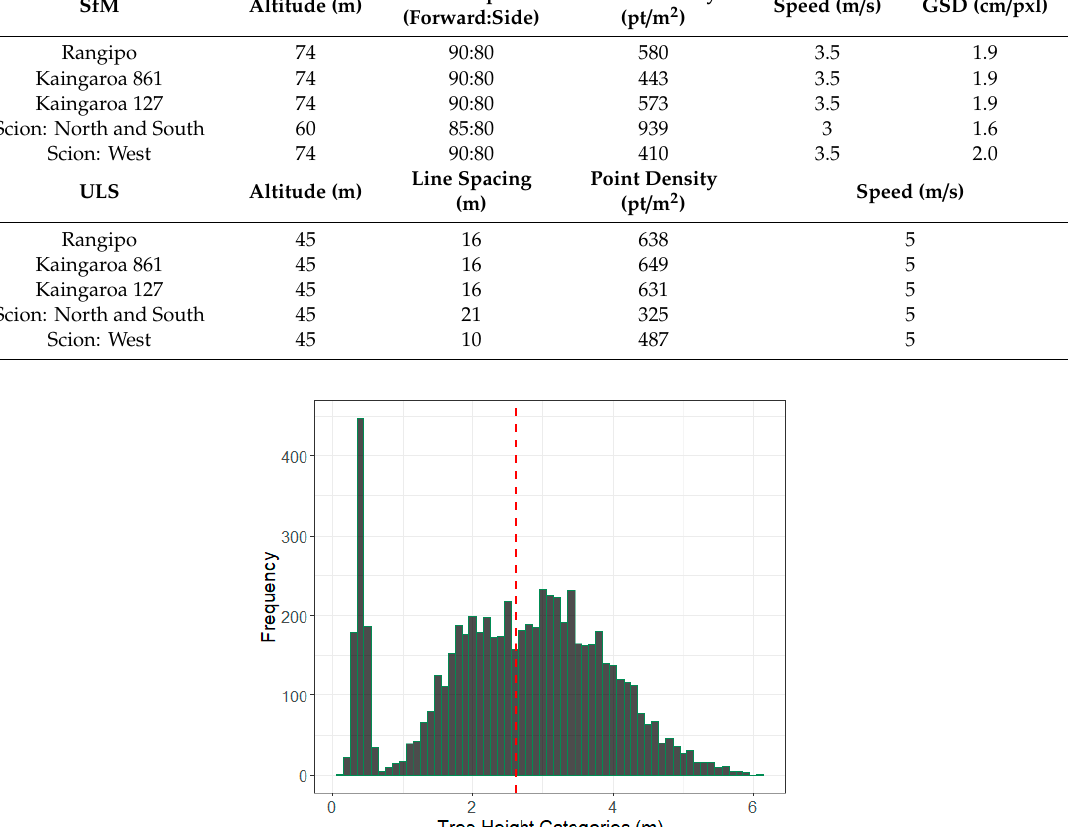
Table 2. Unmanned aerial vehicle (UAV) flight parameters for data captures. SfM